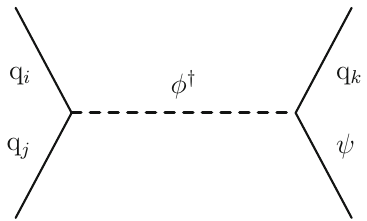
Fig. 8 Diagram for the mono- φ model, where a colored scalar φ